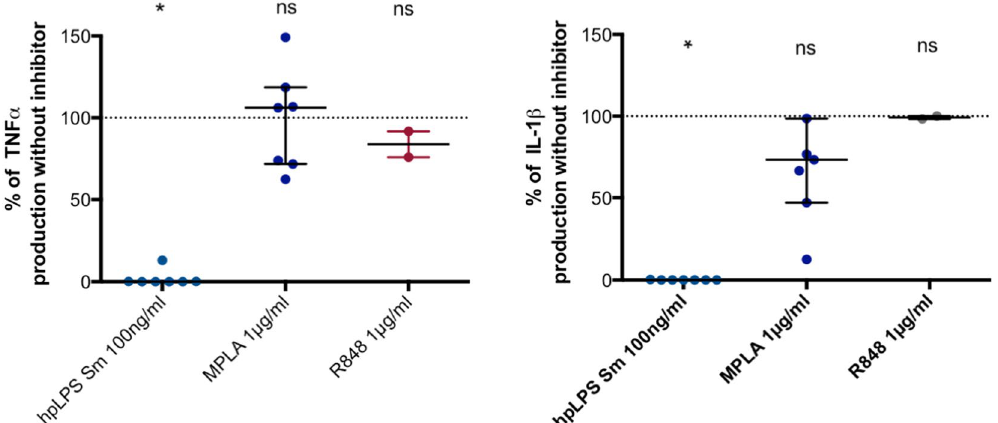
Figure 4. TNF and IL-1 β production by highly purified S. abortus equi LPS (hpLPS) (100 ng/ml) or MPLA (1 µ g/ml) or R848 (1 µ g/ml) for different donors in the presence of anti-CD14 antibodies (2.5 µ M). Anti-CD14 antibodies did not affect the cytokine production in the absence of agonists (data not shown). Each dot represents one individual donor. Results are expressed as percent of the individual responses in the absence of antibodies. * p < 0.05.